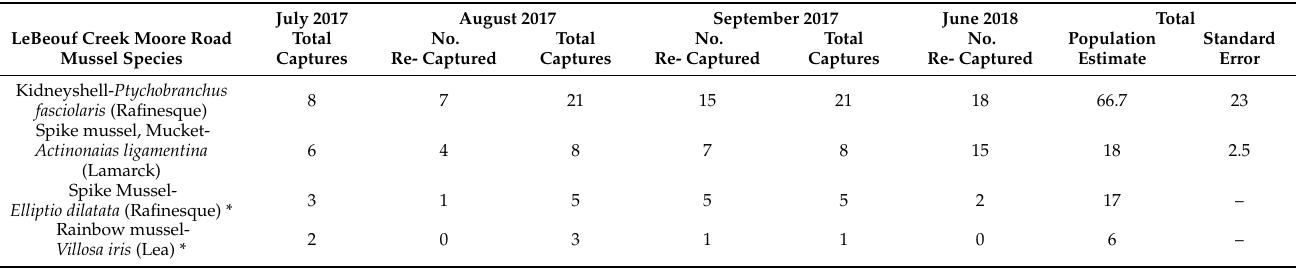
Table 3. Population estimates for the four most common species of mussels at the LeBeouf Creek Moore Road sampling site. Species denoted by an asterisk are populations whose population estimate was less than the sample size. For these species, the true number of individuals observed is reported.